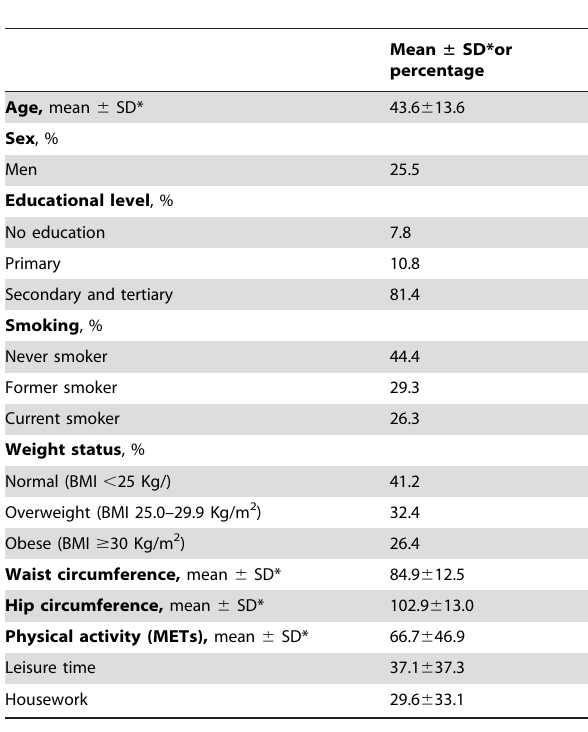
Table 1. Baseline characteristics of study participants (N=